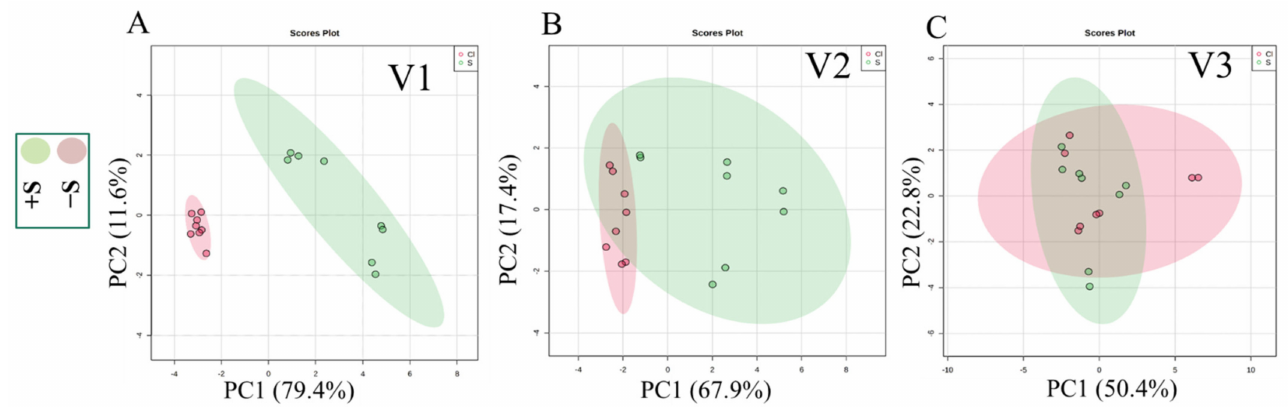
Figure 3. Principal component analysis (PCA) scores plot of the three lettuce cultivars under both +S and − S conditions. conditions; ( A ): V1, ( B ): V2, ( C ): V3.